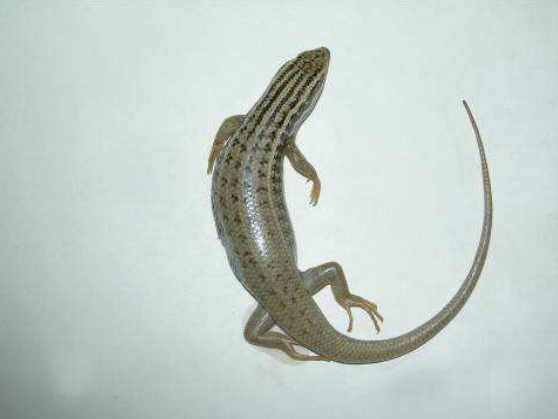
F IGURE 4. Trachylepis septemtaeniata , collected from Firouz Abad (Fars province) (photo by Faizi, 2006).